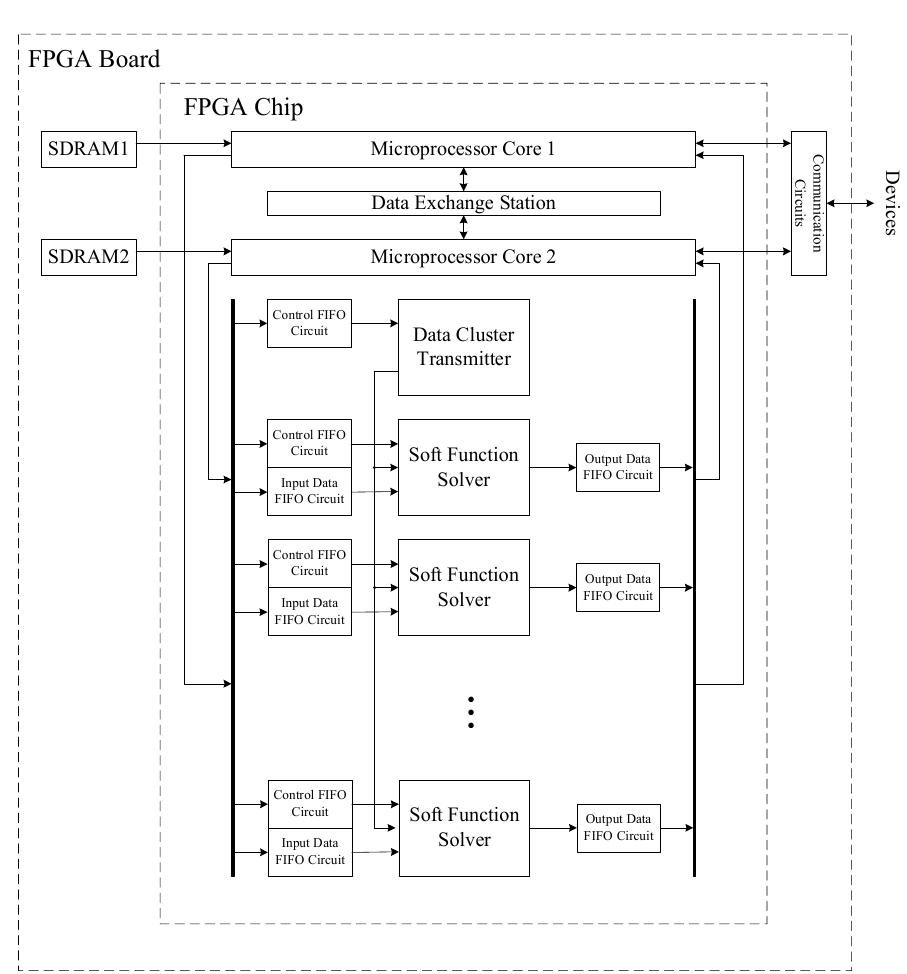
Figure 4. The structure of FRTDS for electromechanical transient simulation.